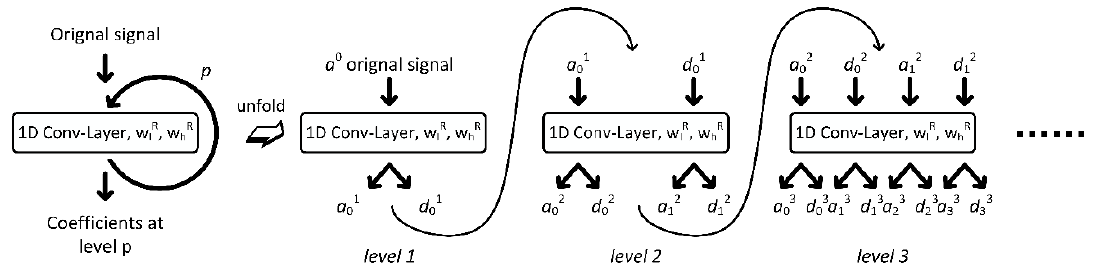
Figure 4. Recursive 1D Conv-Layer for multilevel wavelet packet transform.